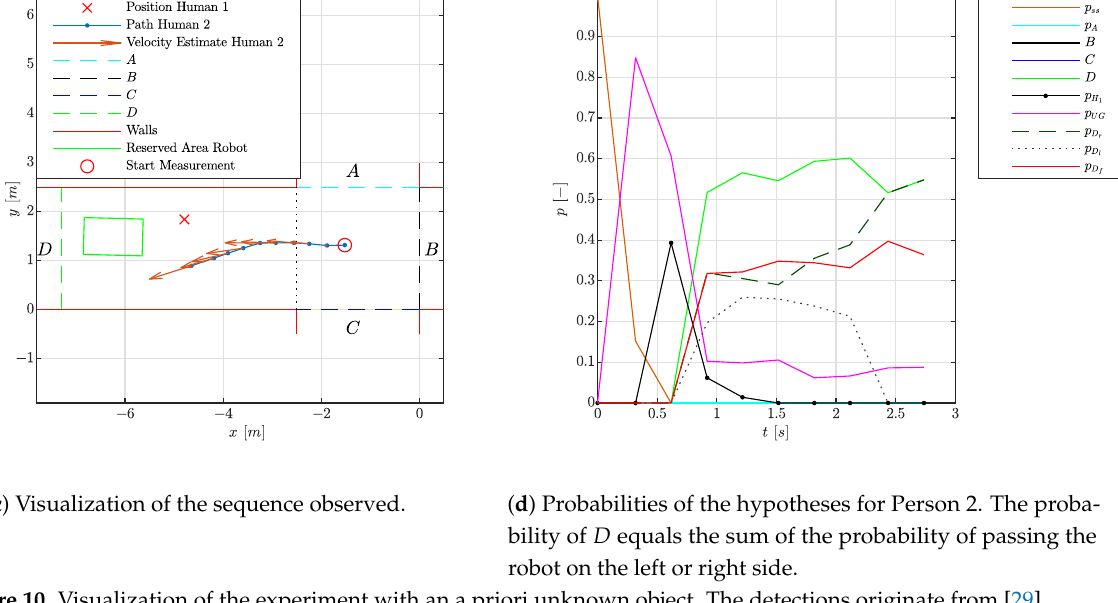
Figure 10. Visualization of the experiment with an a priori unknown object. The detections originate from [29].